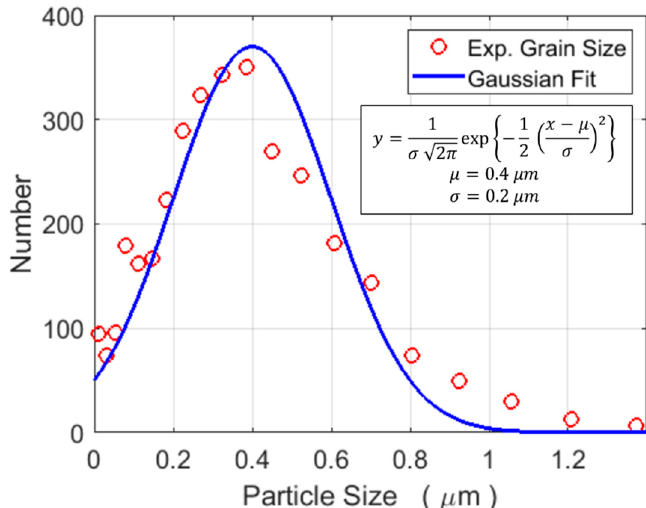
Figure 3. Experimental WC grain size distribution based on the EBSD inspection. The distribution contains information on three IPF maps (one shown in Figure 2, while the other two are not shown here) that cover an overall surface area of about 1000 μ m 2 . In the Gaussian fit equation, x and y account for the “Number” and “Particle Size” axes, respectively, while μ and σ are the mean and standard deviation, respectively.